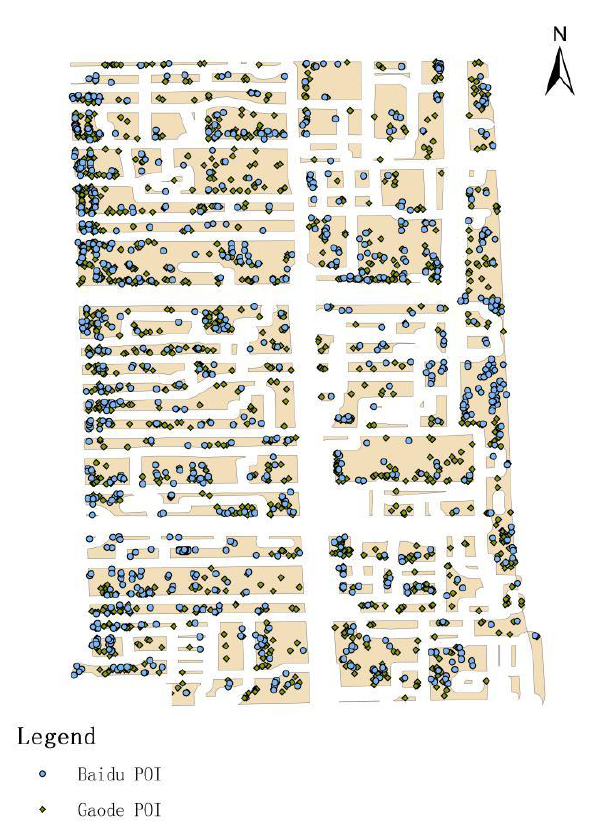
Figure 2 . Study area and data.